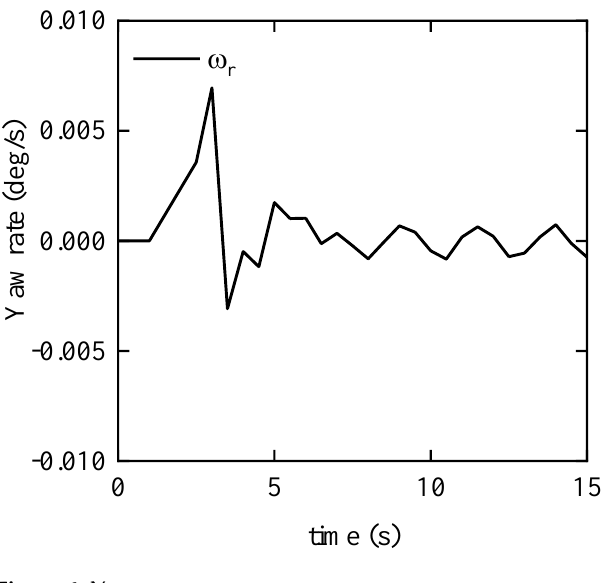
Figure 6. Yaw rate. Figure 6. Yaw